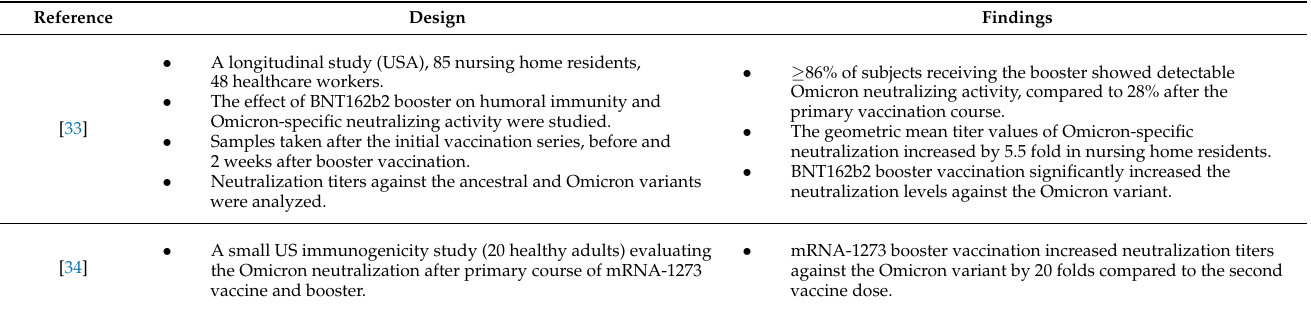
Table 1. Summary of studies evaluating the Omicron-neutralizing activity of the first COVID-19 vaccine